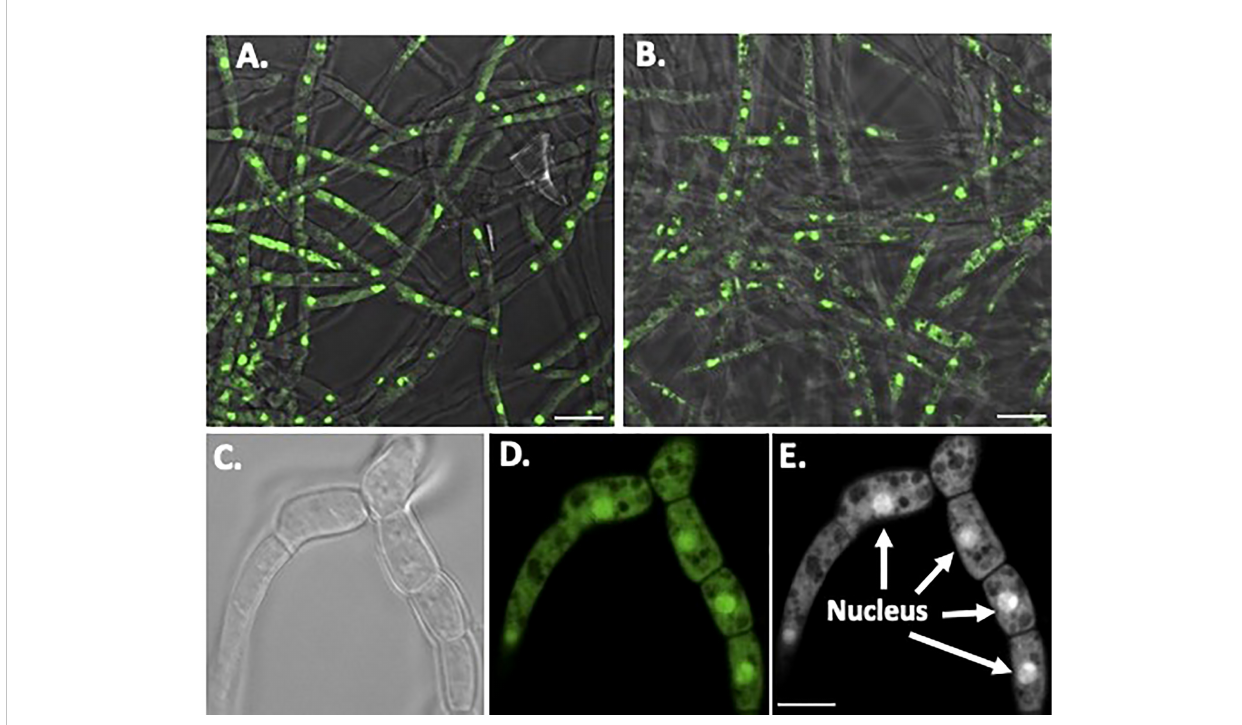
FIGURE 6 Nuclear Staining of O. ophidiicola Hyphae. Comparison of merged bright transparent fi eld and fl uorescence nuclear staining (Green) between O. ophidiicola FL panel (A) and O. ophidiicola TX panel (B) . Lower set of panels show the hyphae branch point of O. ophidiicola TX fi rst in the light fi eld panel (C) then nuclear orange staining panel (D) . Black and white of nuclear staining and de fi ned septate hyphae panel (E) . Bars: A and B = 10 µm; C, D, and E = 5